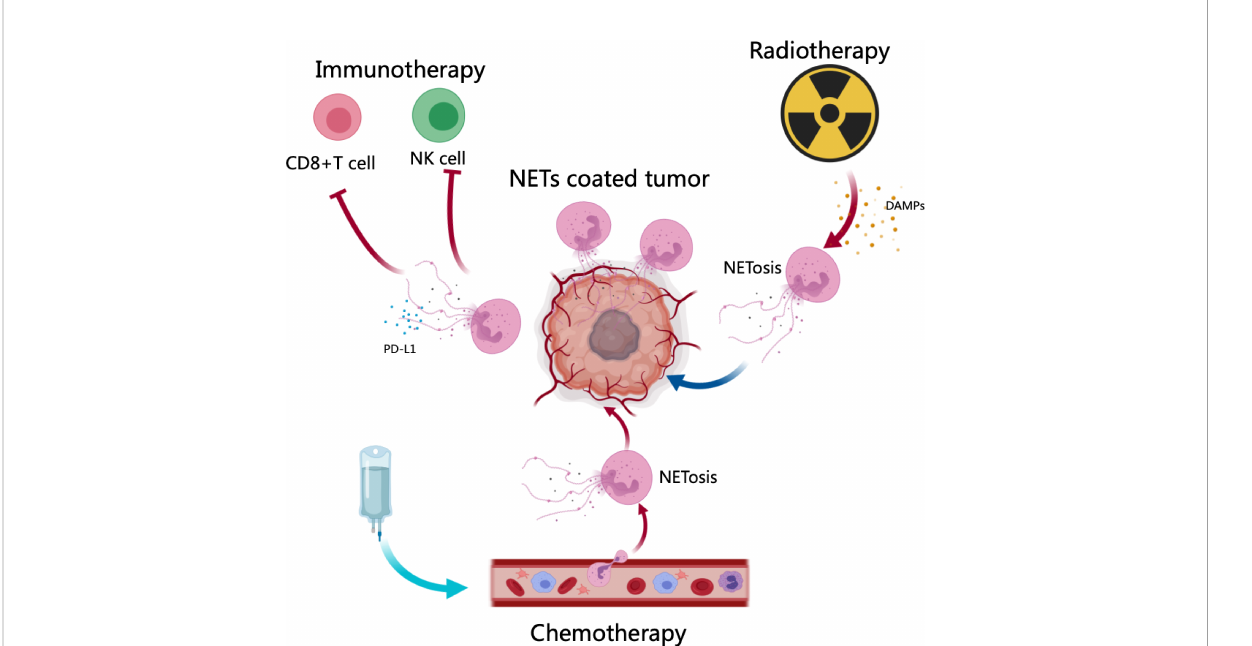
FIGURE 2 NETs in cancer therapy resistance. After chemotherapy and radiotherapy, DAMPs (HMGB1) or other signals from cancer cells induce NET generation, contributing to therapy resistance. Neutrophils in tumor microenvironments expelled NETs, which protected tumor cells from cytotoxicity through CD8+ T cells and NK In addition, NETs decorated with PD-L1 neutralized the function of CD8+ T cells, resulting in checkpoint blockade in